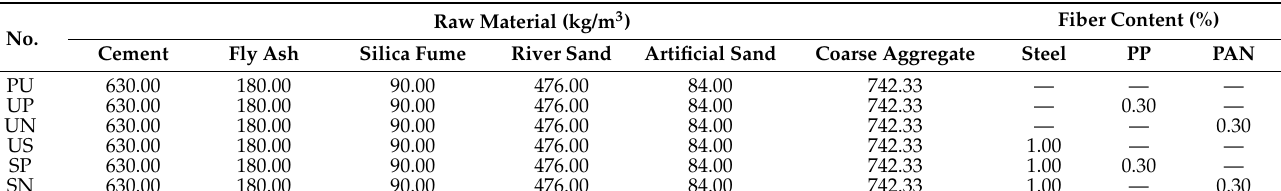
Table 3. Test mix ratios.